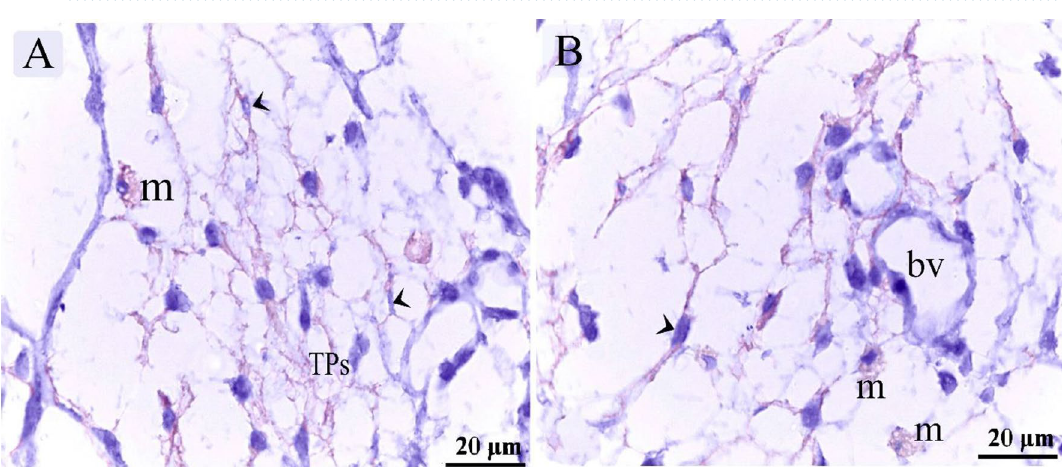
Figure 6. Immunohistochemical staining of the neck skin of quail embryos at day 8 using VEGF. ( A ) VEGF + ve TCs (arrowheads) located around the macrophages (m). ( B ) VEGF + ve perivascular TCs (arrowheads). Note the blood vessels